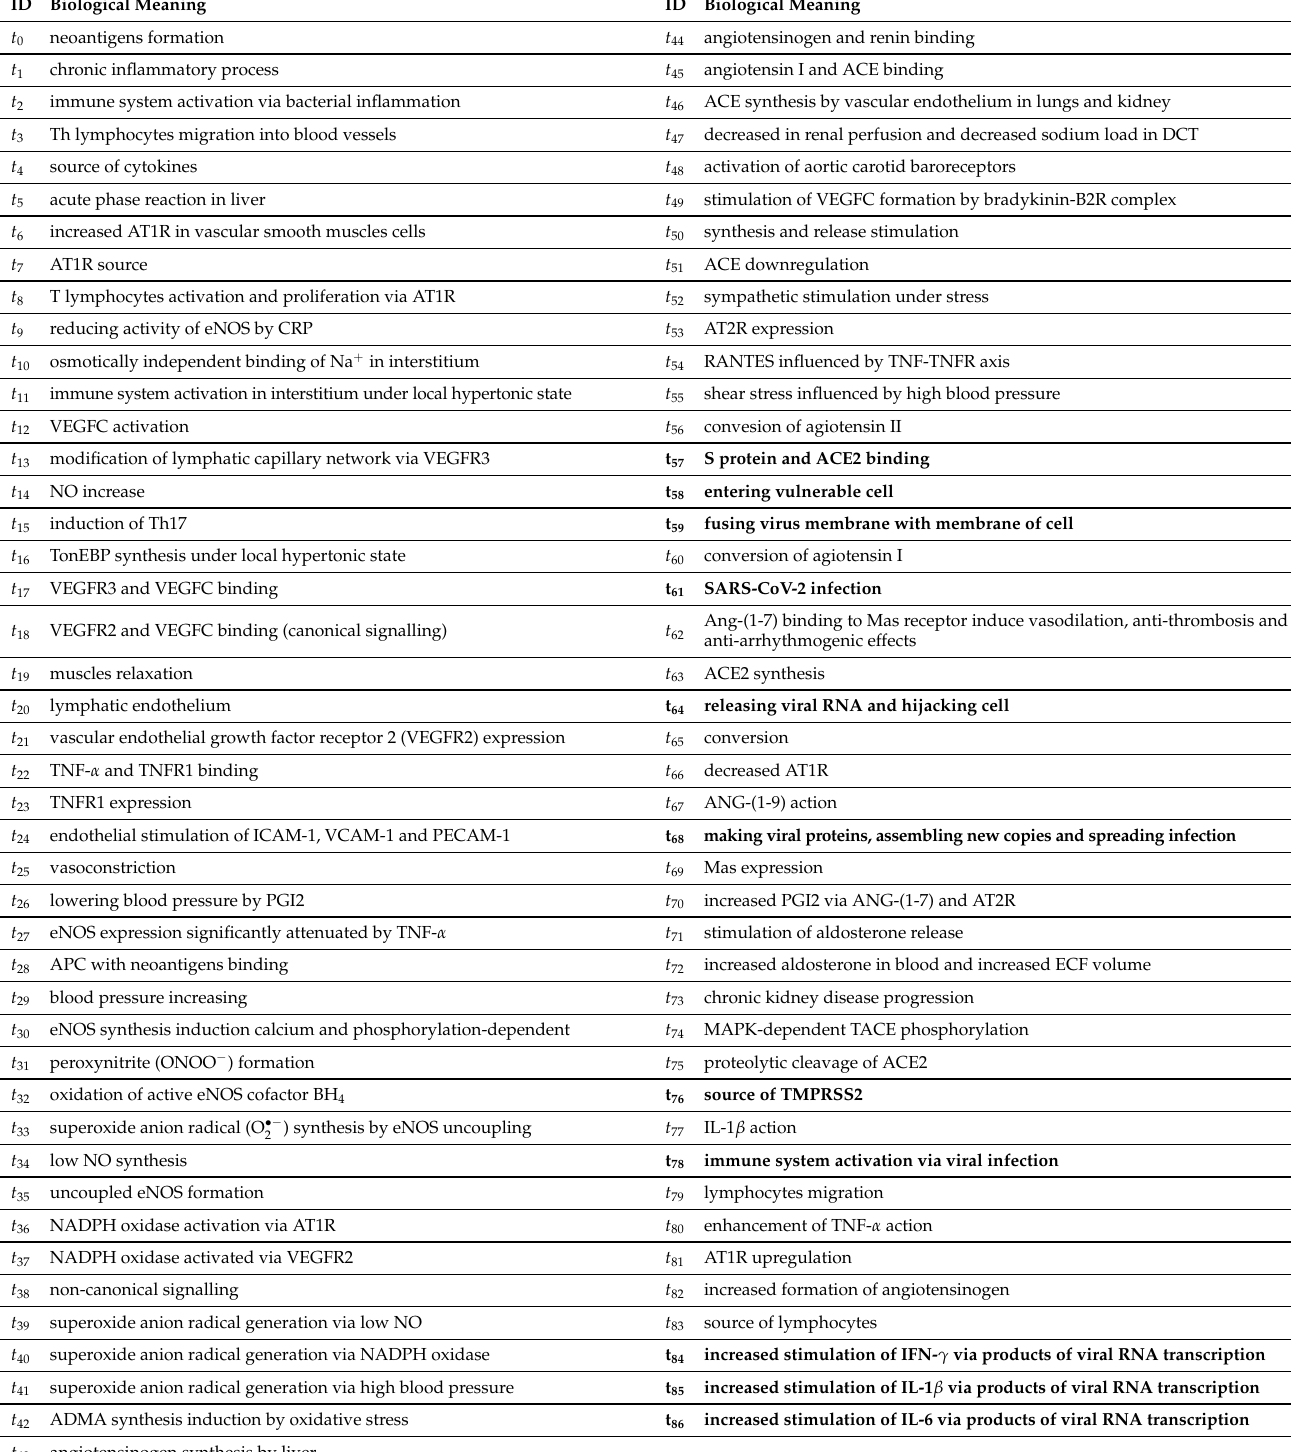
Table 1. List of transitions of the model with